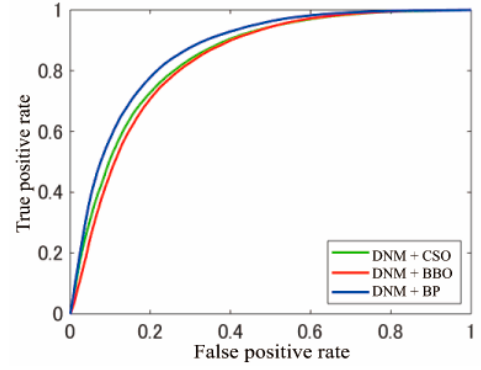
Electronics 2020 , 9 , x FOR PEER REVIEW Figure 9. Receiver operating characteristic (ROC) of each method in F1. Figure 9. Receiver operating characteristic (ROC) of each method in F1.